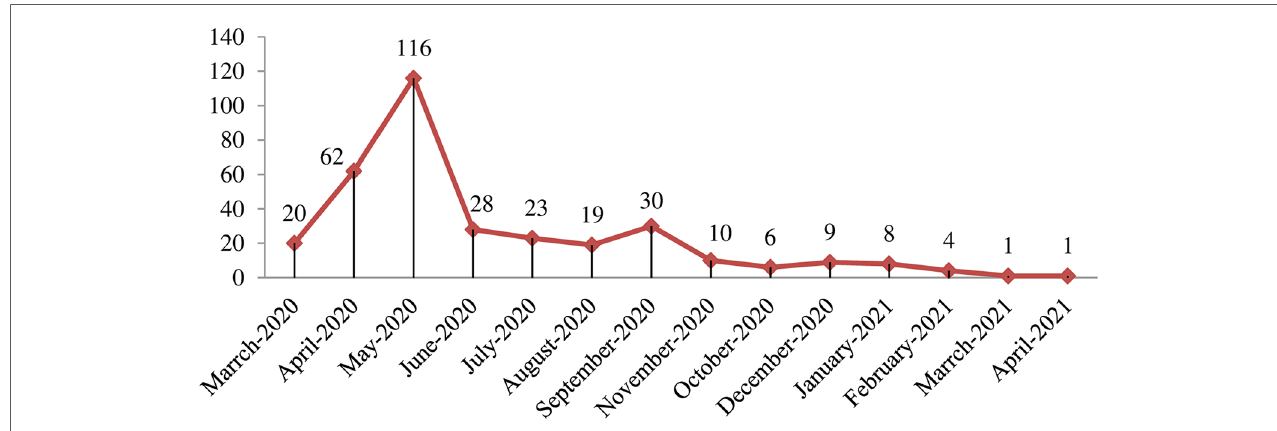
FIGURE 1 Conceptual framework for factors affecting intimate partner violence against women of reproductive age.